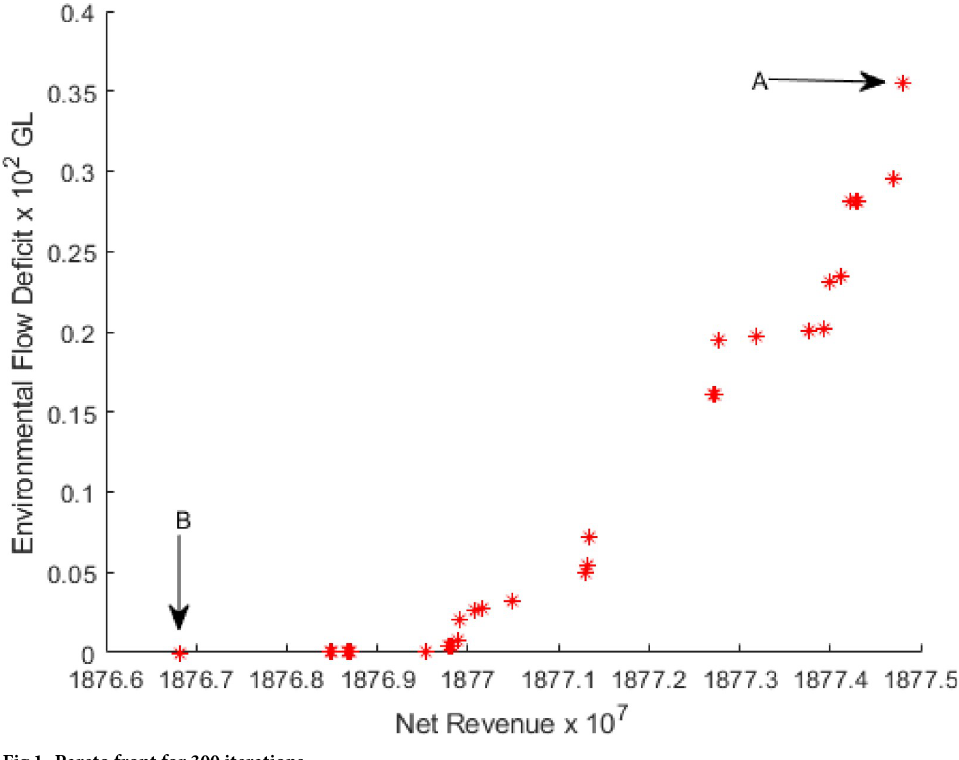
Fig 1. Pareto front for 300 iterations.